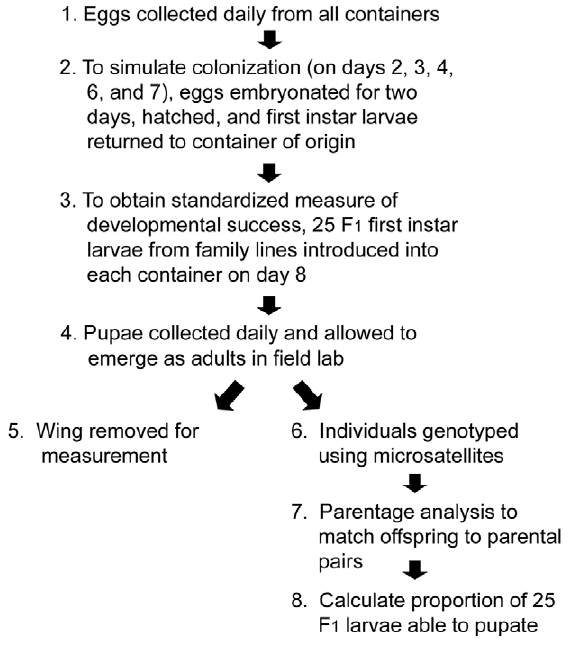
Figure 2. Flowchart of preference-performance field experi- mental design. Four container treatments were set out in each of 20 houses in Iquitos, Peru (80 containers total). Larvae originating from field-collected eggs (for the purpose of monitoring oviposition) were re- introduced into the same container to simulate colonization. Twenty- five F 1 larvae from laboratory families were introduced into each container on day 8 to compare juvenile developmental success.